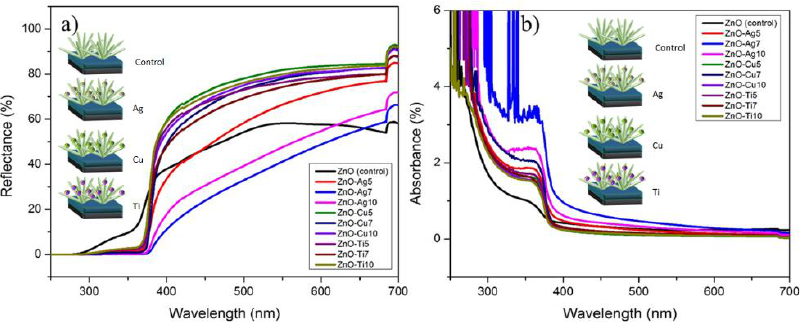
Figure 3. UV-visible spectrum charts of ZnO NFs, ZnO-Ag (5, 7, and 10), ZnO-Cu (5, 7, and 10), and ZnO-Ti (5, 7, and 10) with chart ( a ) displaying reflectance and chart ( b ) displaying absorbance.